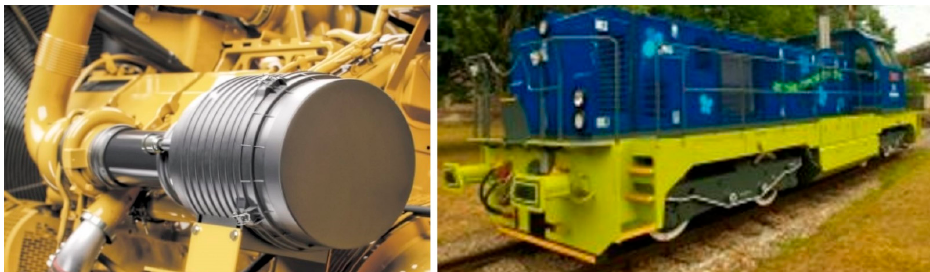
Figure 8. CNG engine and its application in an experimental rail